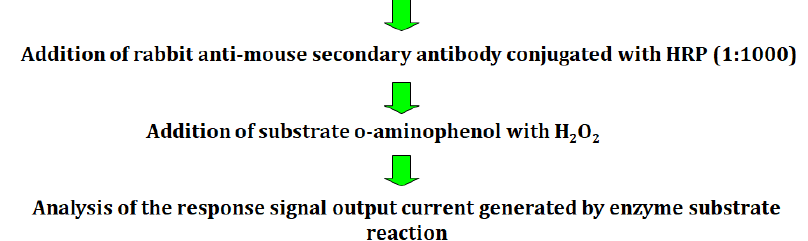
Figure 5. A schematic illustration depicting the optimization of Salmonella antigen cell concentration for Salmonella detection.